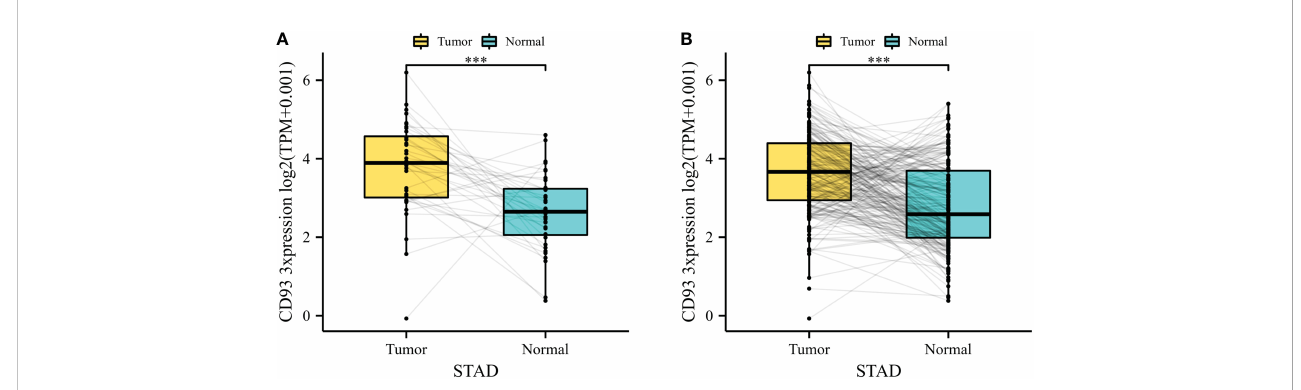
FIGURE 1 (A) CD93 expression difference between stomach adenocarcinoma (STAD) and adjacent normal tissue in The Cancer Genome Atlas (TCGA) database. (B) CD93 expression difference between STAD and adjacent normal tissue in the integrated database of TCGA and GTEx. *** p <